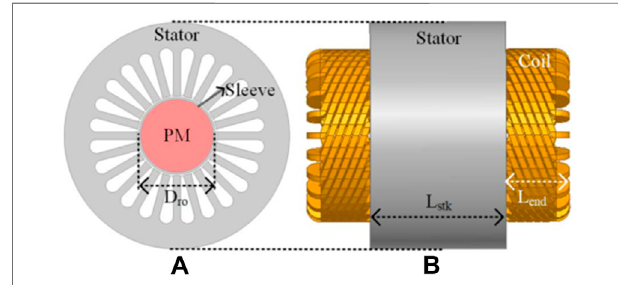
FIGURE 14 | Structure of a high-speed PMSM. (A) 2D model. (B) 3D shape of the PMSM model (Gang-Hyeon Jang,